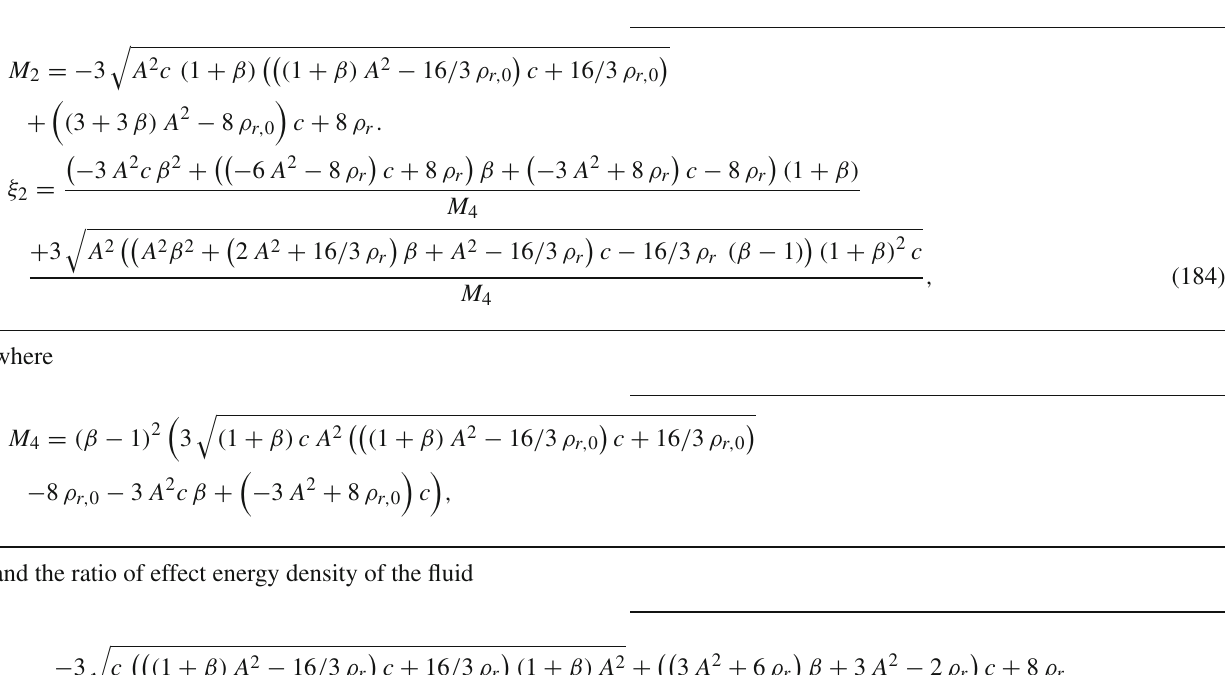
Fig. 13 w ef f ( 1 , 2 ) versus a for radiation-torsion system for MGCG for β = 10, c = 1 . 2 and A = 1